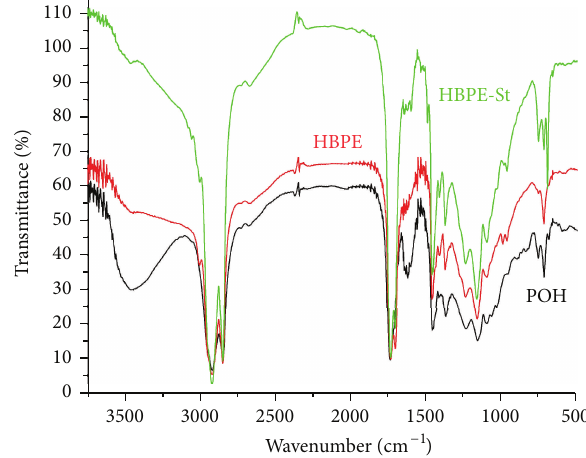
Figure 1: FT-IR spectrum of POH, HBE, and